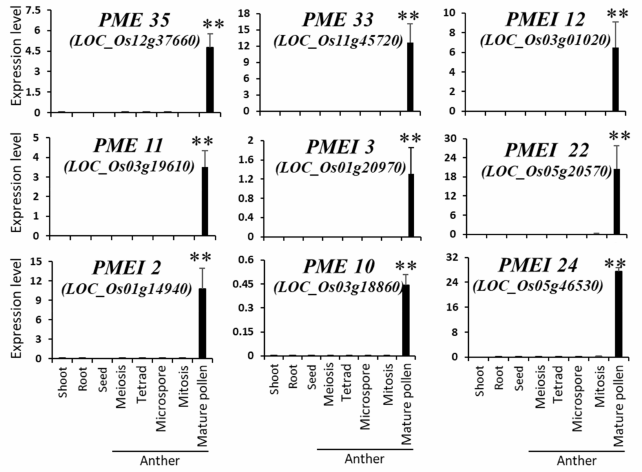
Figure 5. qRT-PCR examination. Validation of meta-expression patterns of pollen-expressed OsPME s and OsPMEI s using qRT-PCR. OsUbi1 was used for internal control. ** p -value < 0.01, based on t -tests.